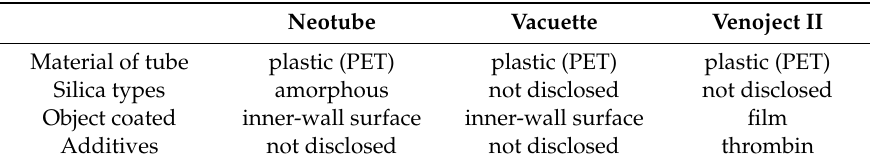
Table 1. Characteristics of plastic tubes used in this